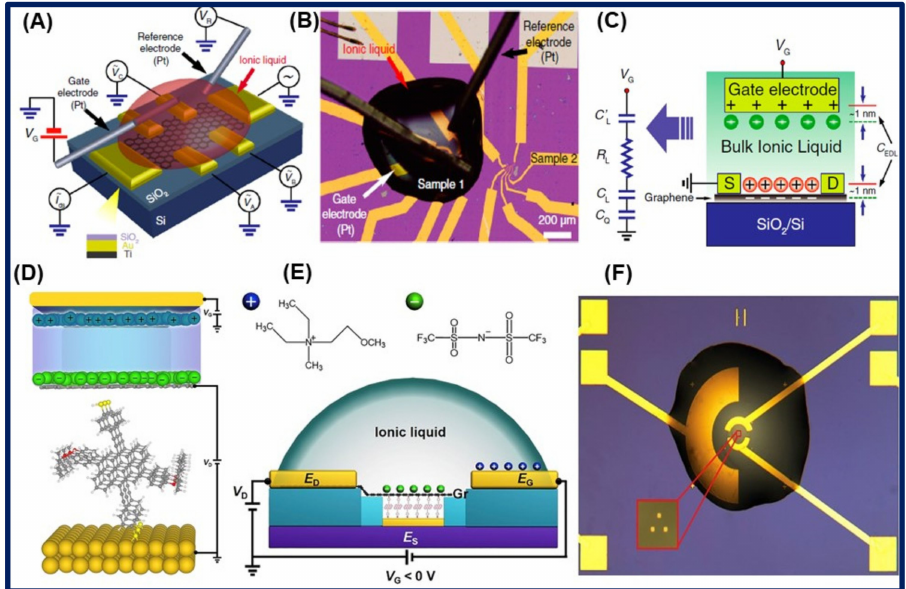
Figure 11. Electric double-layer GR devices. ( A ) A schematic representation of a device, including the bias configuration used in the electrical measurements. ( B ) Optical microscope image of an actual device. ( C ) A schematic cross-section of GR EDLTs, together with the equivalent electrical circuit describing its operation. Reprinted with permission from Ref. [149]. Copyright 2011, PNAS Publishing. ( D – F ) Schematic illustration for the setup of the device with a vertical IL gate through GR layer to SAMs and molecular structures for DEME + cation and TFSI − anion. Reprinted with permission from Ref. [150]. Copyright 2019,